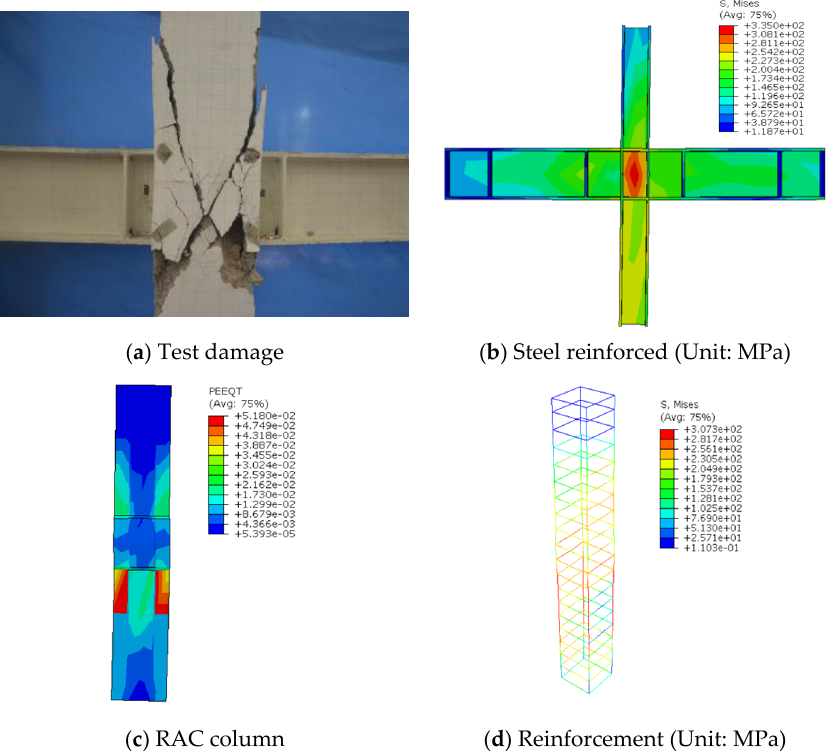
Figure 15. Comparison of test and simulation results of CFJ5.